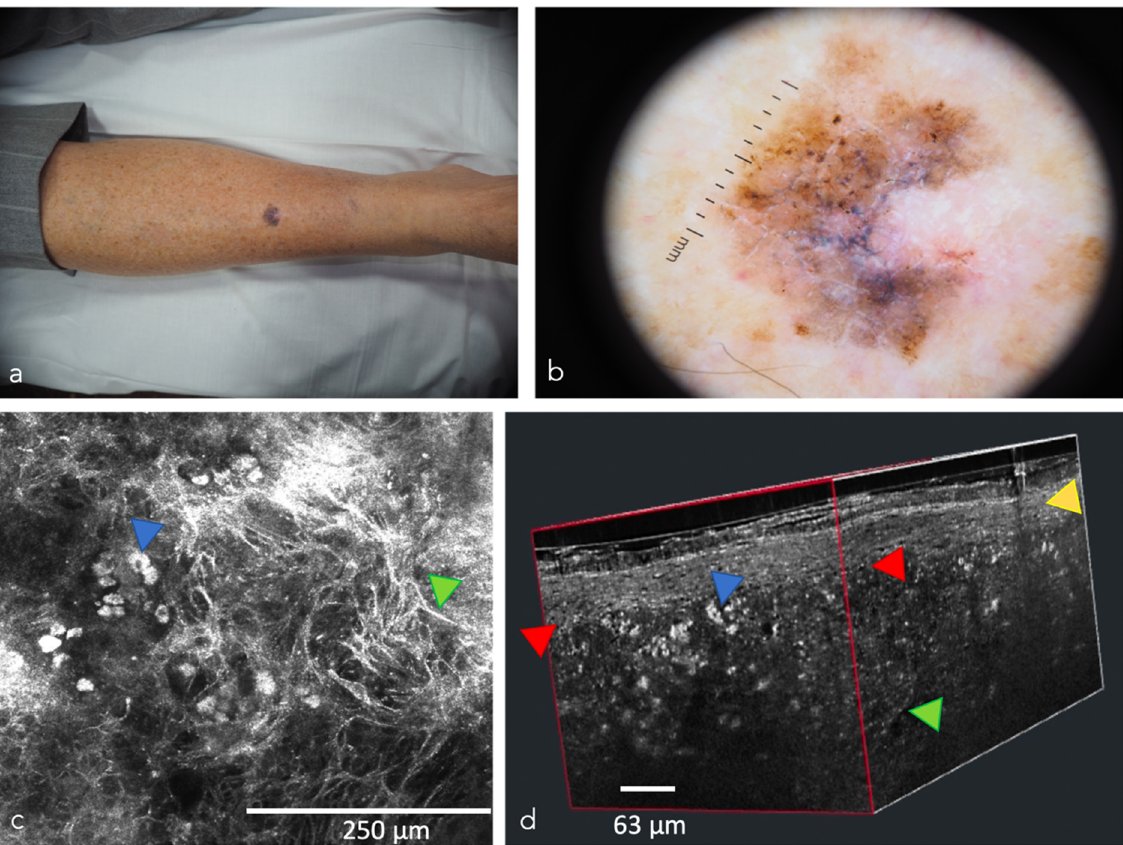
Figure 8. Melanoma in three different imaging techniques: ( a ) Clinical picture; ( b ) Dermoscopic image; ( c ) Reflectance confocal microscopy: cellular atypia (blue arrow) and dendritic cells (green arrow); ( d ) 3D block of LC-OCT: irregular epidermis (yellow arrow), disruption of the dermoepidermal junction (red arrow), atypical nests with atypical (blue arrow) and dendritic cells (green arrow).